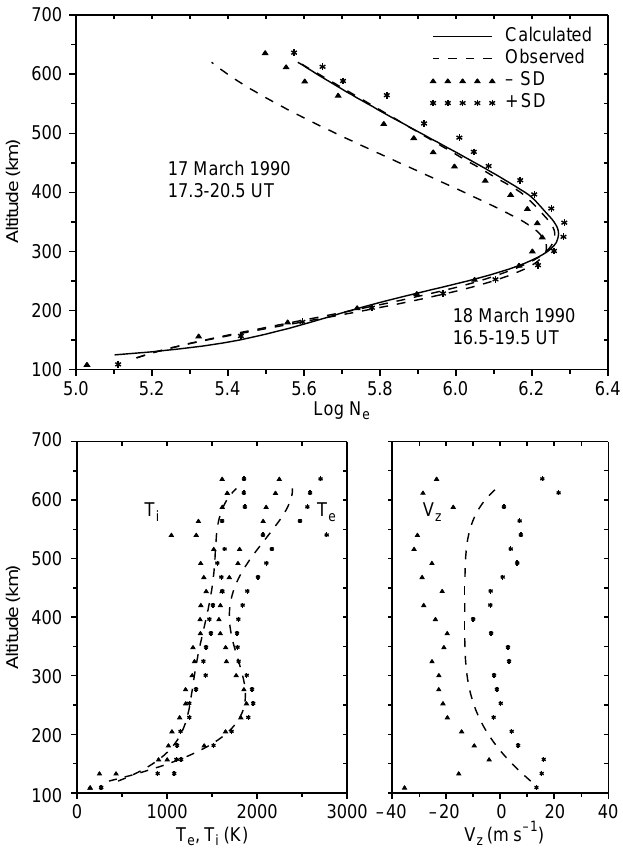
Fig. 2. Observed along with (cid:6) standard deviations and calculated N e (h) profiles for the disturbed day March 18, 1990 in comparison with the observed quiet time profile of March 17, 1990. Observed T e , T i and V z along with (cid:6) standard deviations median profiles used in our calculations are given in the